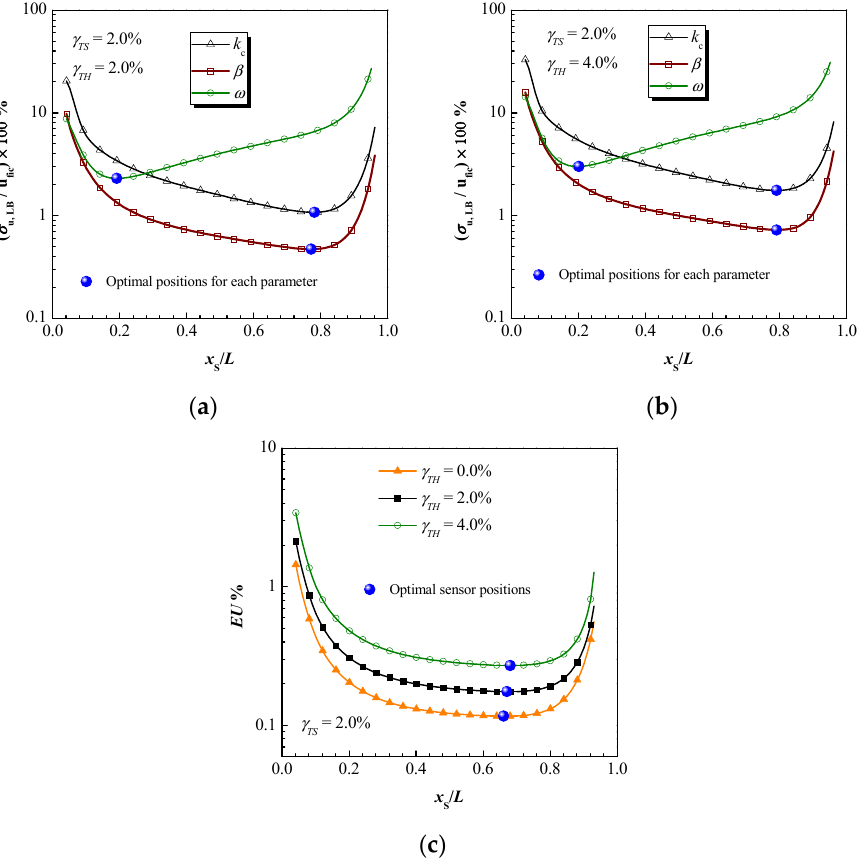
γ = 2.0%, ( b ) the values of TH